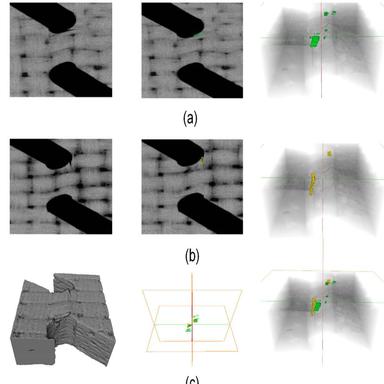
The Initial damage mark: (a) Crack mark of warp yarn; (b) Crack mark of weft yarn; (c) Distribution of initial damage crack.